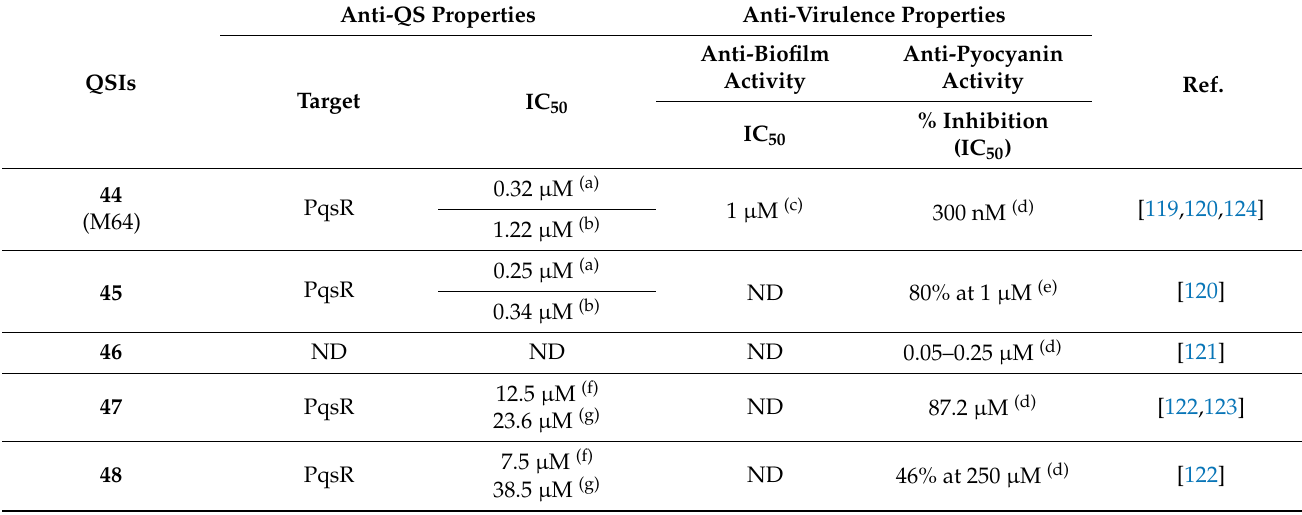
ND = Not Determined; Anti-QS evaluations carried out using reporter gene assays on (a) P. aeruginosa (PAO1-L, mCTX:P pqsA-lux ); (b) P. aeruginosa (PA14, mCTX:P pqsA-lux ); Anti-virulence evaluations carried out on/by (c) static biofilm assay with P. aeruginosa (PA14)/CV dyeing and OD measurement; (d) P. aeruginosa (PA14)/OD measurement; (e) P. aeruginosa (PA14, mCTX:P pqsA-lux )/OD measurement; (f) E. coli (DH5 α pEAL08-2) in presence of PQS (50nM); (g) P. aeruginosa (PA14 ∆ pqsA, pEAL08-2) in presence of PQS (50